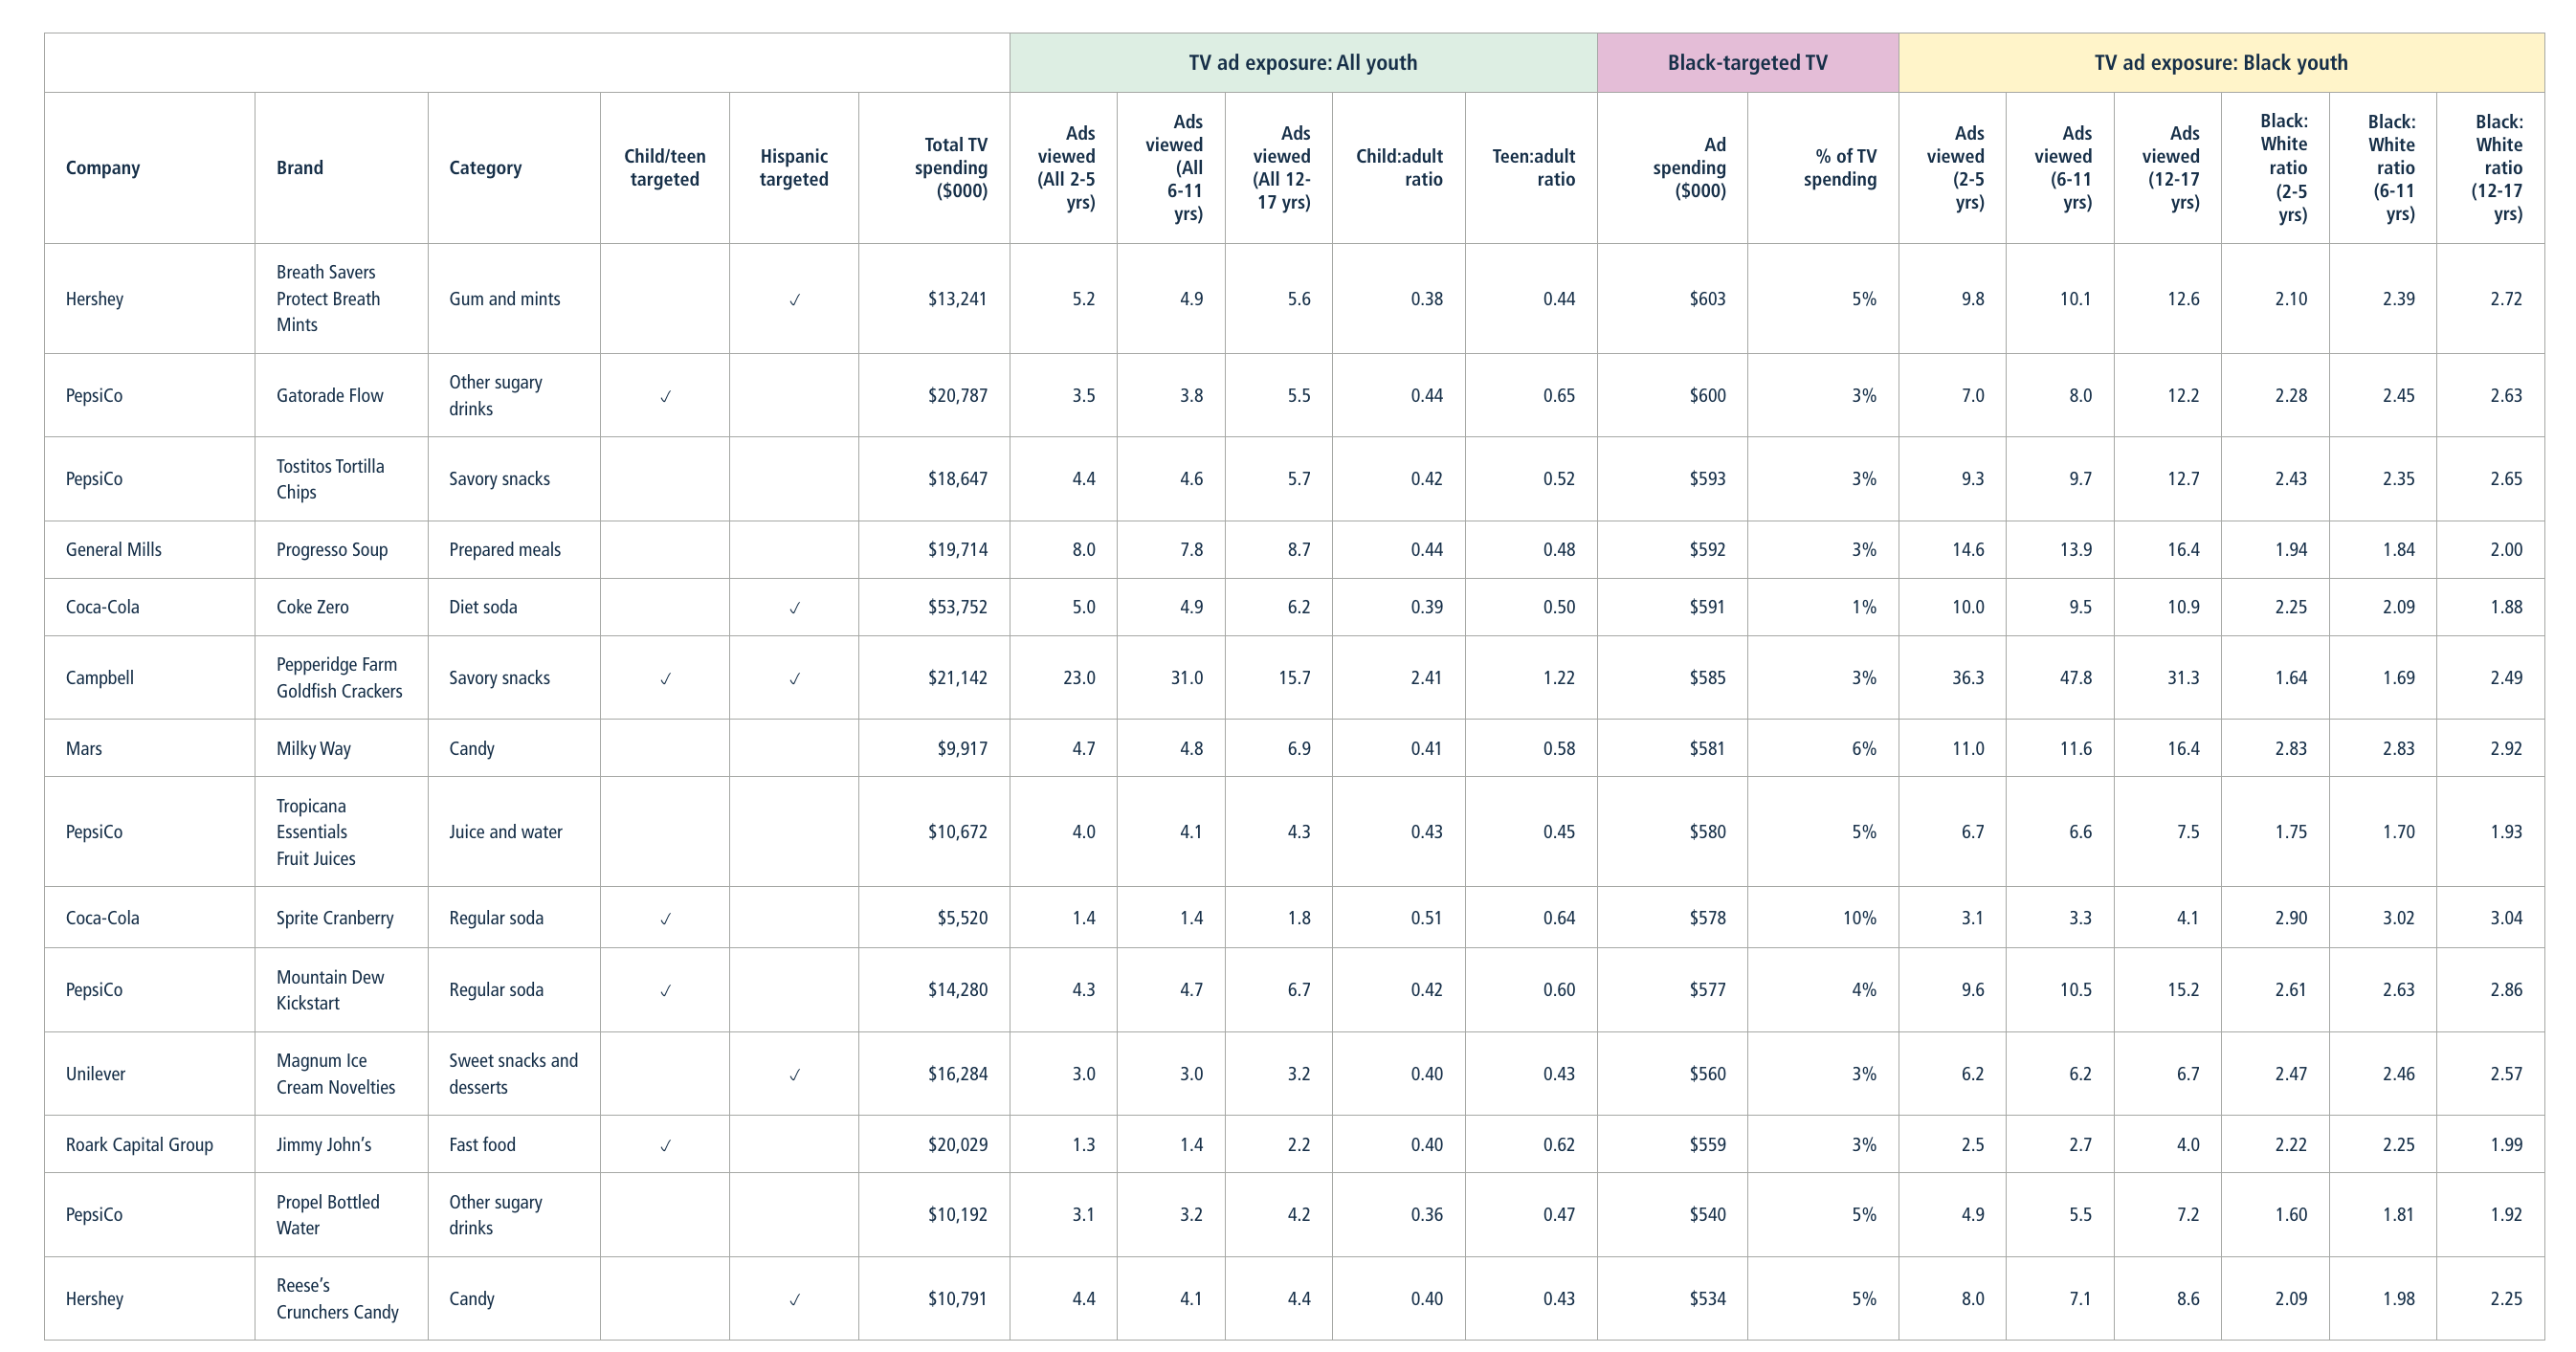
TABLE 3. BRANDS TARGETED TO BLACK CONSUMERS